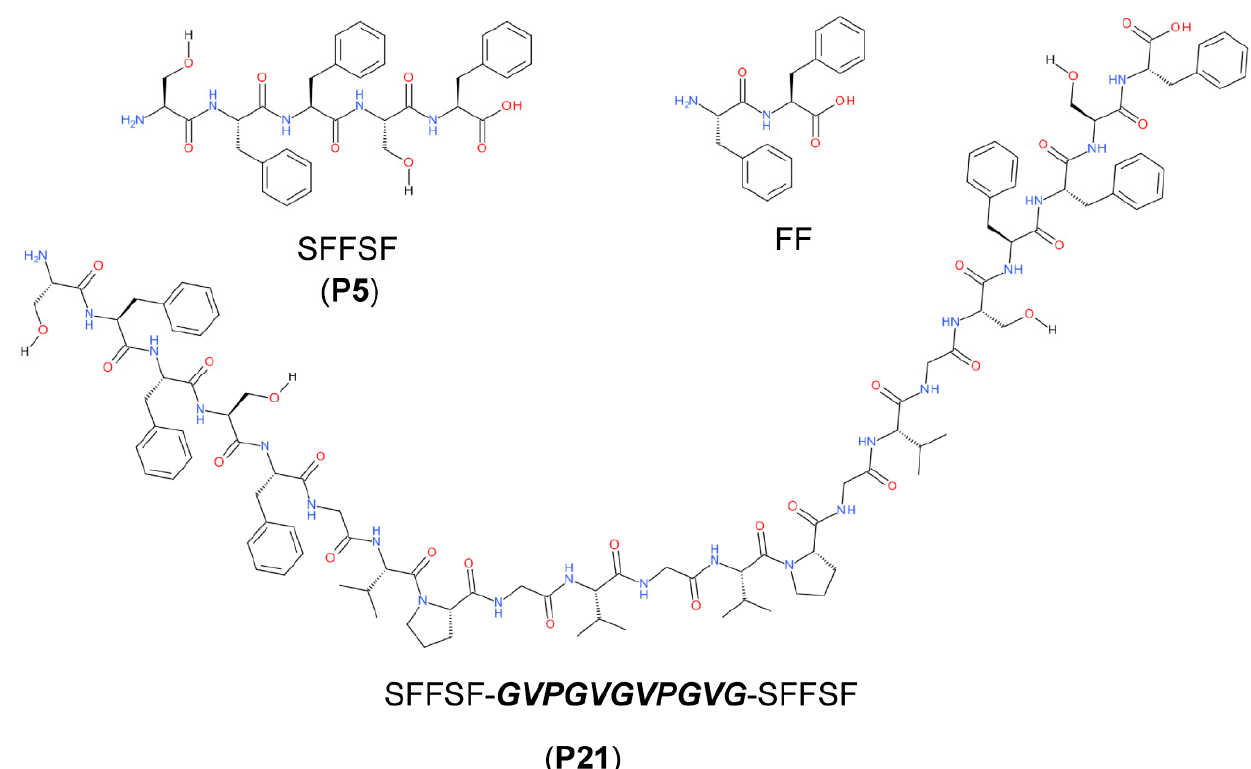
Figure 1. Chemical structures of P5, P21, and FF peptides.